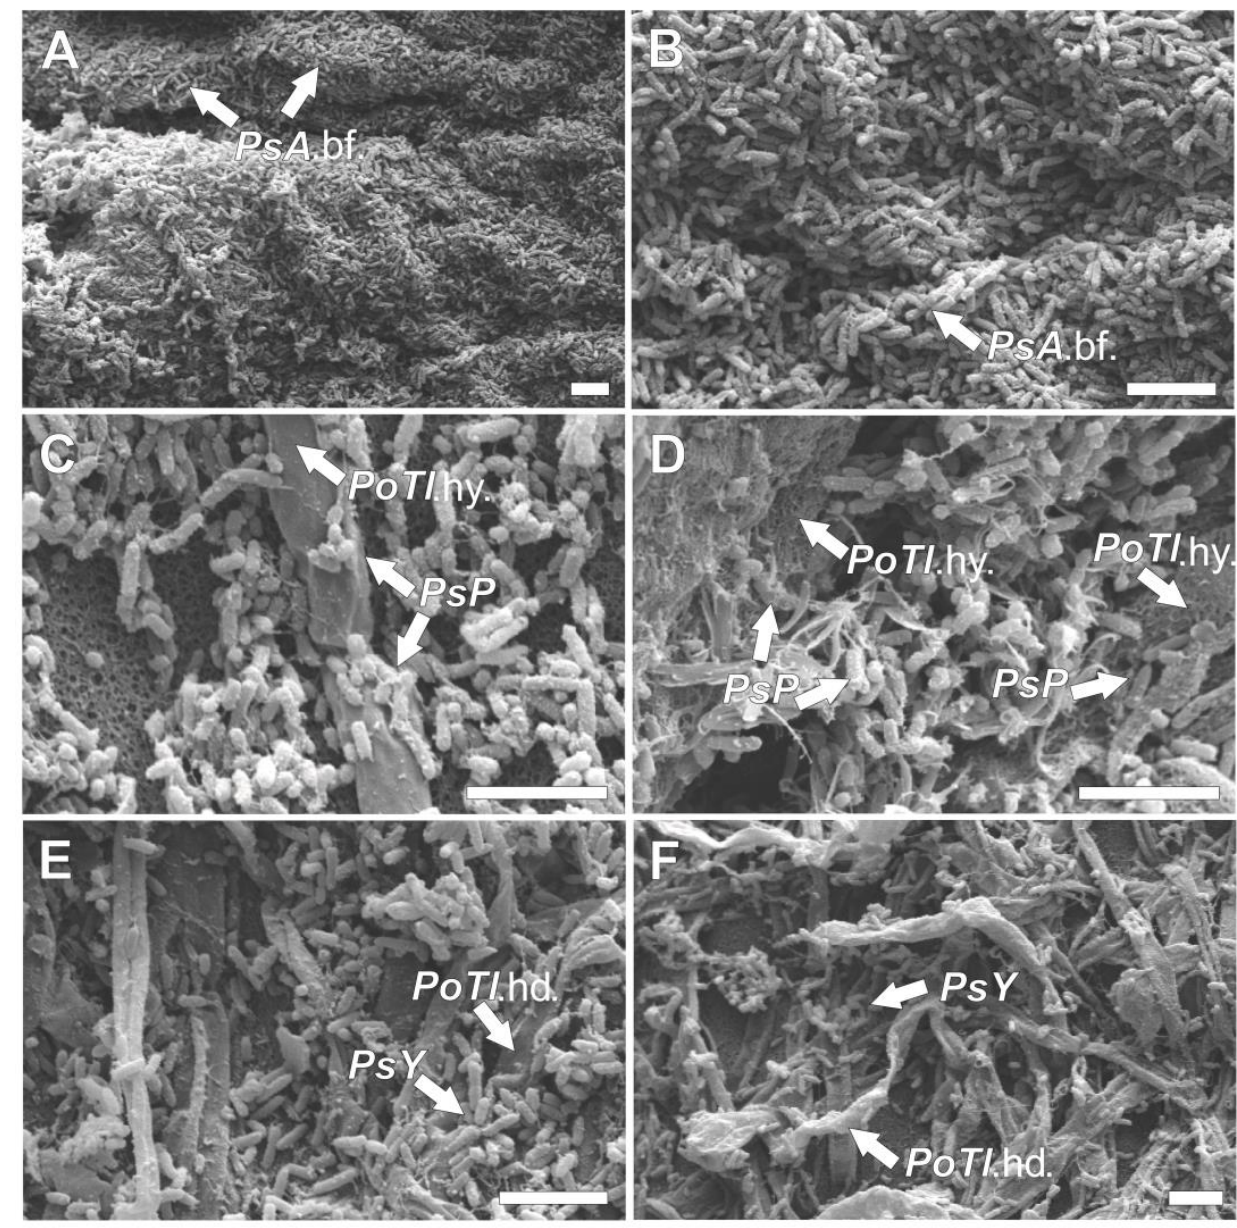
Figure 5. In vitro antagonism by strains of Pseudomonas species against Pyricularia oryzae Triticum lineage ( PoTl ) on PDA medium. ( A , B ): Bacterial biofilm formation by Pseudomonas wayambapalatensis ‘Amana’ ( PsA .bf.) completely covering the PoTl hyphae. ( C , D ): the bacterial cells of Pseudomonas sp. nov. ‘Poti’ ( PsP ) growing and colonizing PoTl hyphae ( PoTl .hy.). ( E , F ): Colonization of Pseudomonas sp. nov. ‘Yara’ ( PsY ) above PoTl pathogen, with hyphae damage ( PoTl .hd.) ( F ). Scale bars: 5 µ m. In comparison, we also performed SEM analyses of the in vitro interaction of the T. koningiopsis Cachara isolate against PoTl . Extensive hyphae growth and abundant sporulation of Trichoderma over the PoTl aerial mycelium were observed (Figure 6A,B,D–F). Mycoparasitism was also detected, which was characterized by Trichoderma forming a hyphal coiled structure to parasitize PoTl (Figure